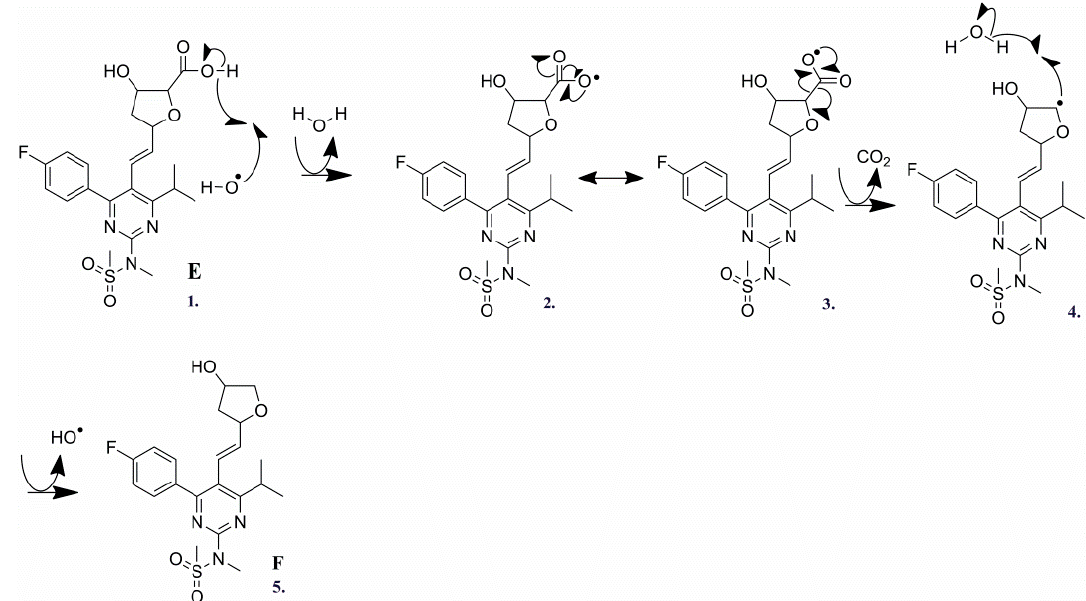
Scheme 5. Mechanism of the product F formation by decarboxylation of product E.